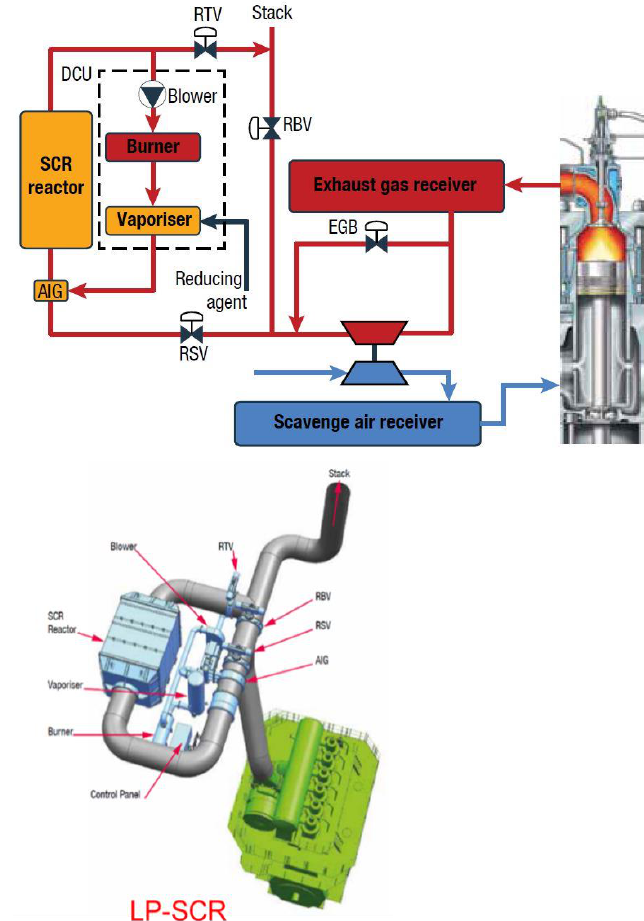
Figure 5. LP-SCR system developed by Doosan Corporation [18].